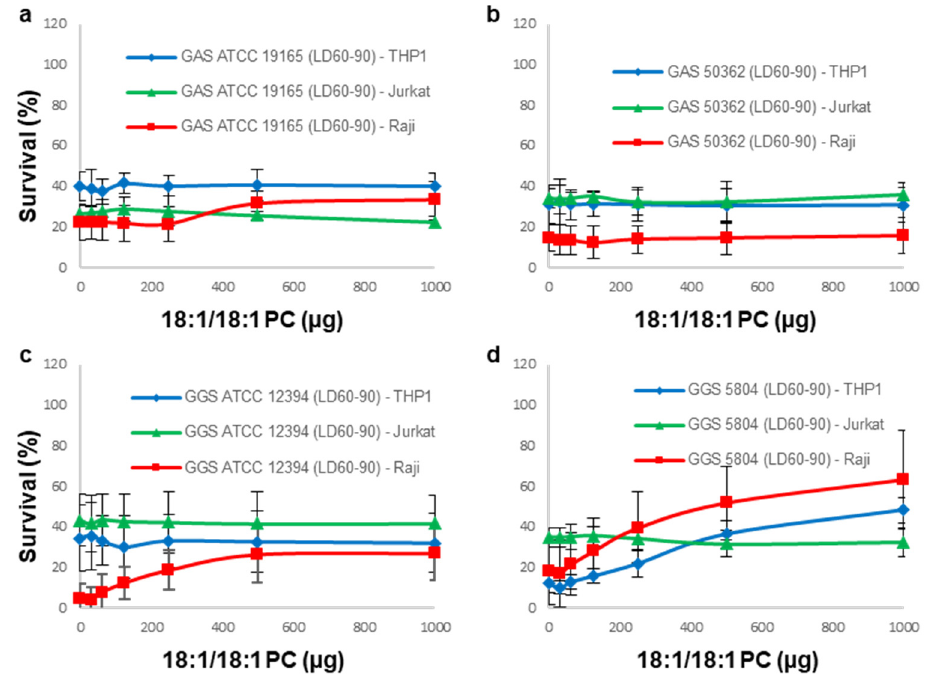
Figure 3. Inhibition of cytolysins secreted by GAS and GGS by liposomes composed of 18:1/18:1 PC. 18:1/18:1 PC-liposomes displayed no protection towards any immune cell line used in the current study treated with either of the GAS supernatants ( a , b ). No protection for THP-1 or Jurkat cell lines and partial protection for the Raji cell line were observed against the GGS ATCC 12394 supernatant (~20% of ~LD 95 , p -value < 0.03) ( c ). No protection for Jurkat cells and partial protection for THP-1 cells (~30% of ~LD 90 , p -value < 0.005) and Raji cells (~45% of ~LD 85 , p -value < 0.006) were observed against the GGS 5804 supernatant ( d ). Errors bars = mean ± SD; N ≥